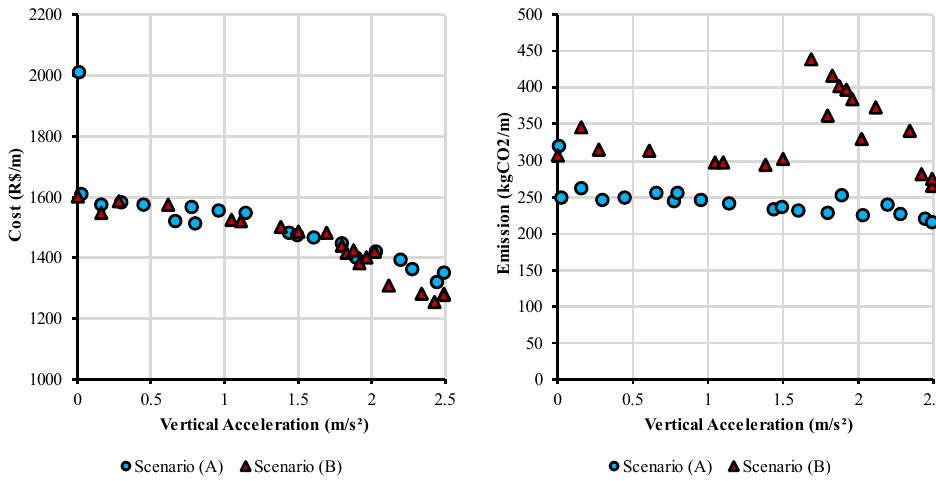
Figure 5. Pareto front for vertical acceleration versus cost and emission.